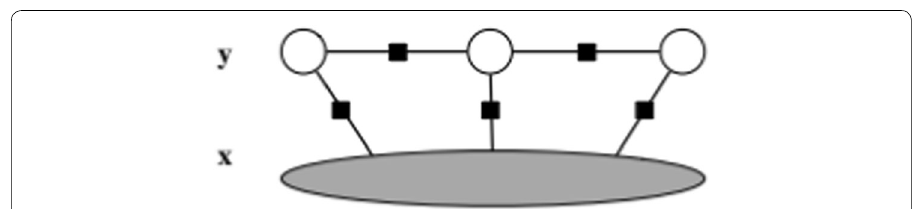
Fig. 3 CRF-transitional states depend on all observations